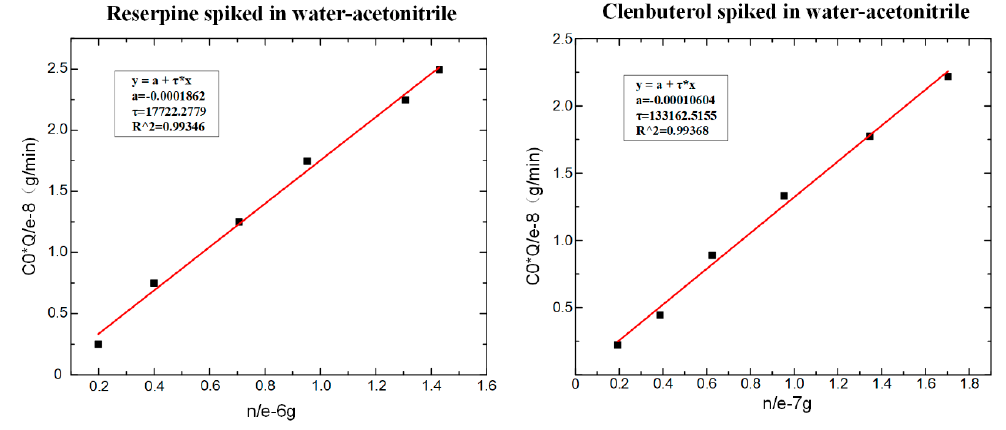
Figure 7. The fitting result of τ . ( a ) The time constant of reserpine. ( b ) The time constant of clenbuterol.